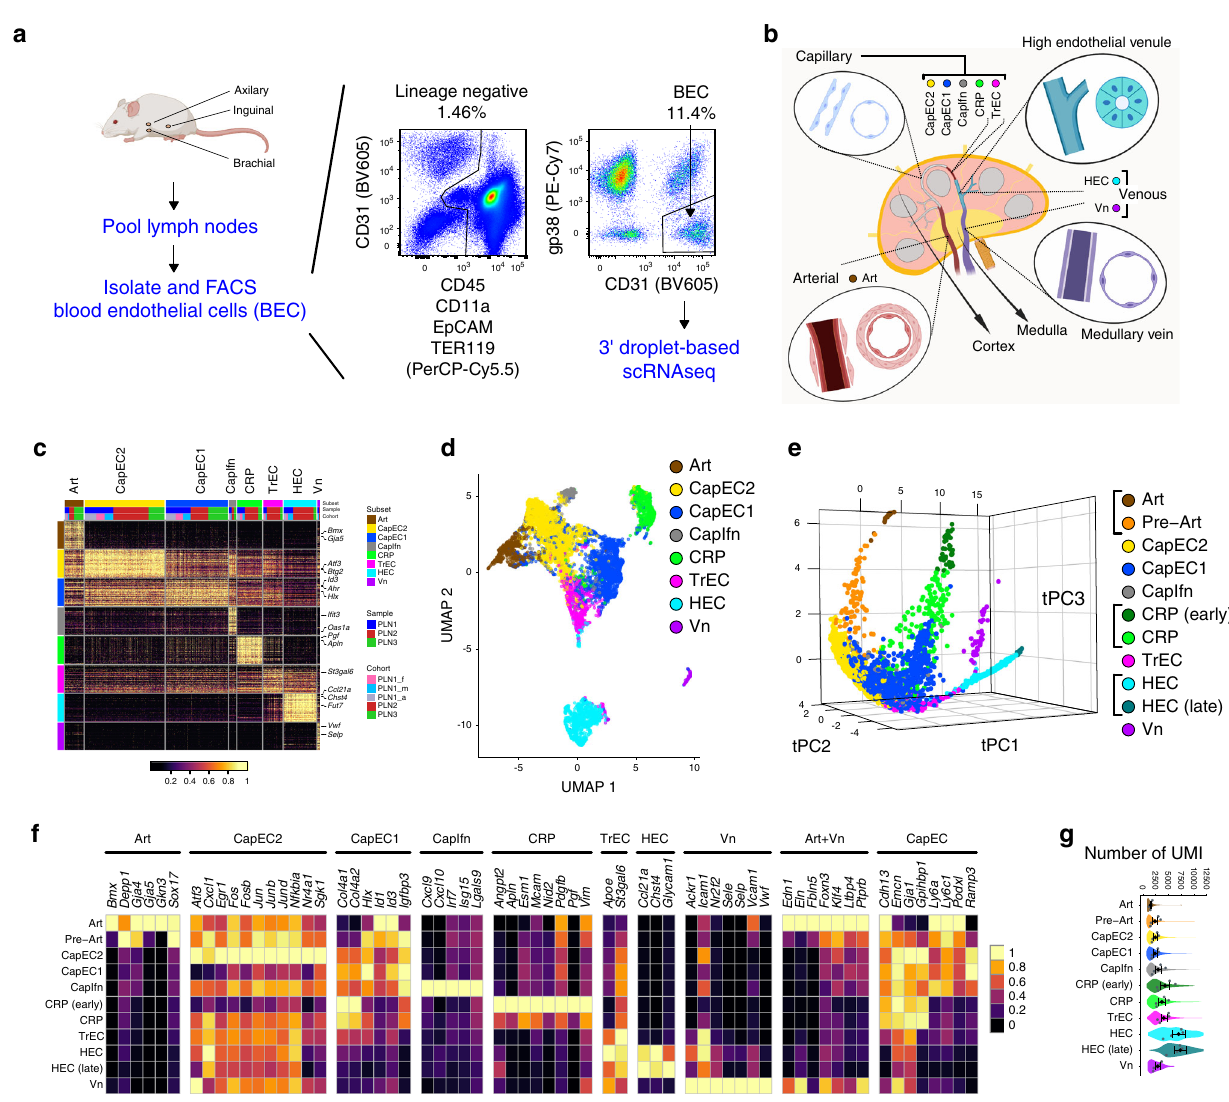
Fig. 1 Single-cell survey of lymph node blood vessel endothelial cells. a Work fl ow schematic. Lymph nodes from adult mice are pooled and dissociated into single cells. Fluorescence activated cell sorting (FACS) is used to isolate blood endothelial cells. scRNAseq (×10 Chromium) is used to pro fi le the cells. Representative FACS plot. b Lymph node schematic depicting the eight major subsets identi fi ed by scRNAseq analysis. c Heatmap of expression of the top 50 differentially and speci fi cally expressed genes for each subset are shown. Subset, sample, and cohort are annotated across the top and select genes on the right. d UMAP plot of 8832 single cells from three samples (four cohorts). Cells are segregated by type: arterial EC (pre-Art), high endothelial cells (HEC), non-HEC veins (Vn), and fi ve capillary phenotype EC (CapEC1, CapEC2, capillary resident progenitors (CRP), transitional EC (TrEC), Interferon- stimulated gene-enriched CapEC (CapIfn). e Computationally predicted relationships visualized in PCA projection of cells aligned in trajectory space using cells from PLN1. Clusters extending to the termini of the arterial, CRP, and HEV branches were further subdivided to distinguish cells most distinct (distant along trajectories) from the bulk of EC (CRP (early), Art, HEC (late; darker shadings). Interactive rendering available: https://stanford.io/2qzJ8Hl. f Selected marker and signature genes for each of the indicated clusters and combinations of clusters (top). Mean expression values from three samples and four cohorts (color scale). g Total transcript counts (UMI; unique molecular identi fi ers) per cell within each subset. Violins show the UMI distribution of all cells. Mean expression values for each of the four independent cohorts (gray dots) and mean and standard error (SEM) of the cohort means are also plotted (black diamonds,